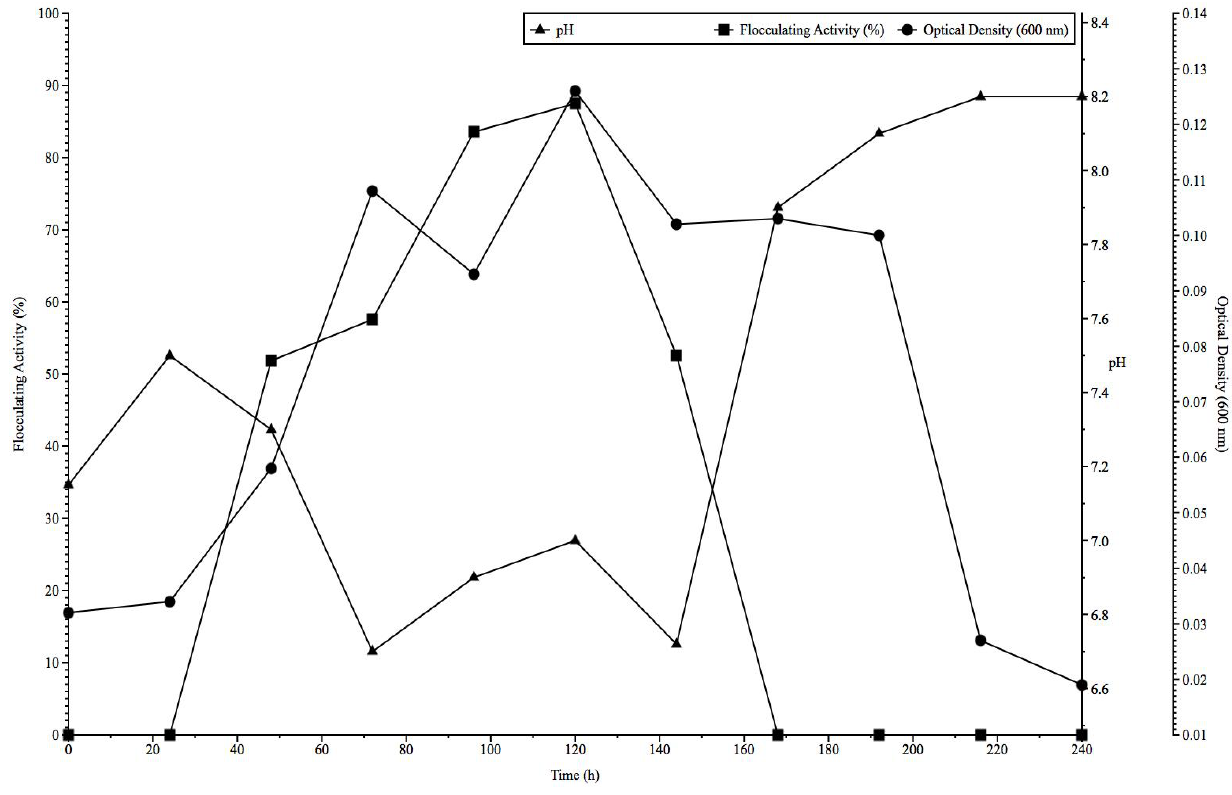
Figure 3. Time course assay of flocculant production by Arthrobacter sp.